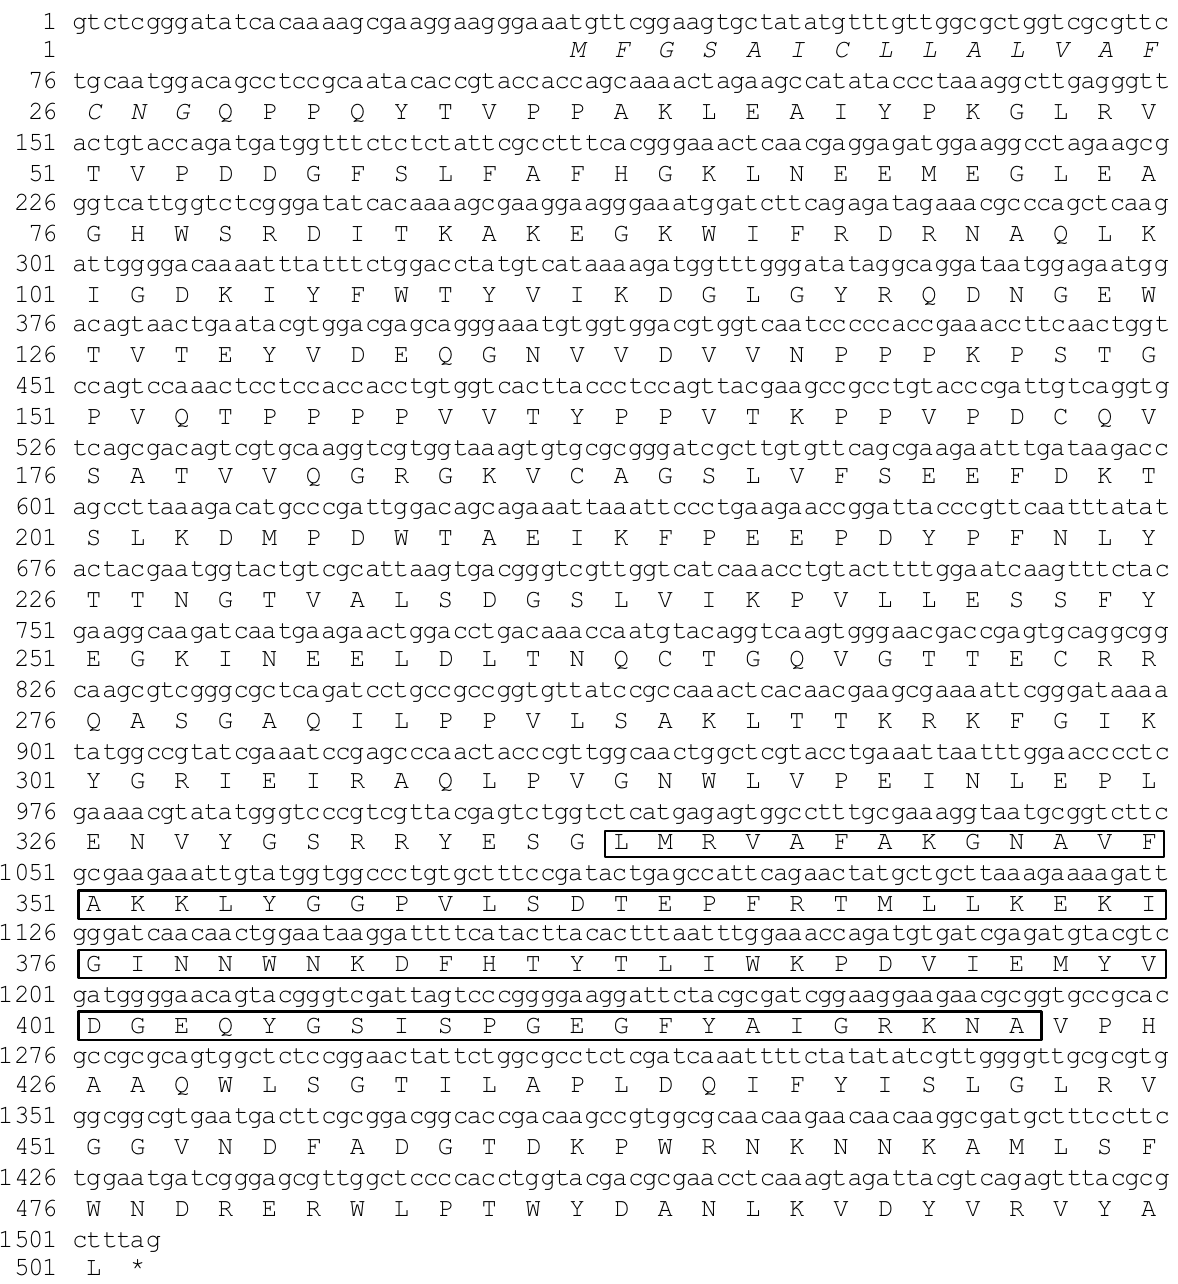
Figure 1. Nucleotide (cid:68)(cid:81)(cid:71)(cid:3)(cid:68)(cid:80)(cid:76)(cid:81)(cid:82)(cid:3)(cid:68)(cid:70)(cid:76)(cid:71)(cid:3)(cid:86)(cid:72)(cid:84)(cid:88)(cid:72)(cid:81)(cid:70)(cid:72)(cid:86)(cid:3)(cid:82)(cid:73)(cid:3)(cid:36)(cid:83)(cid:533)(cid:42)(cid:53)(cid:51)(cid:17)(cid:3)(cid:44)(cid:87)(cid:68)(cid:79)(cid:76)(cid:70)(cid:3)(cid:68)(cid:80)(cid:76)(cid:81)(cid:82)(cid:3)(cid:68)(cid:70)(cid:76)(cid:71)(cid:86)(cid:3)(cid:76)(cid:81)(cid:71)(cid:76)(cid:70)(cid:68)(cid:87)(cid:72)(cid:3)(cid:87)(cid:75)(cid:72)(cid:3)